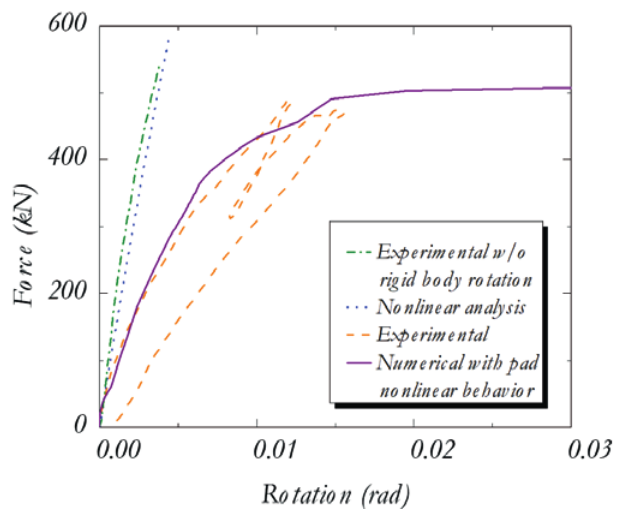
Figure 6 Numerical and experimental load-rotation and load-lateral deflection response of the PCI BT-54 rigid body rotation, respectively. The dashed and solid lines rep- resent respectively the experimental and numerical results of the beam taken into account the behavior of the pad. Figure 7 presents the numerical load versus lateral displacement for PCI BT-54, and in dashed line, the instability load obtained experimentally in [3].